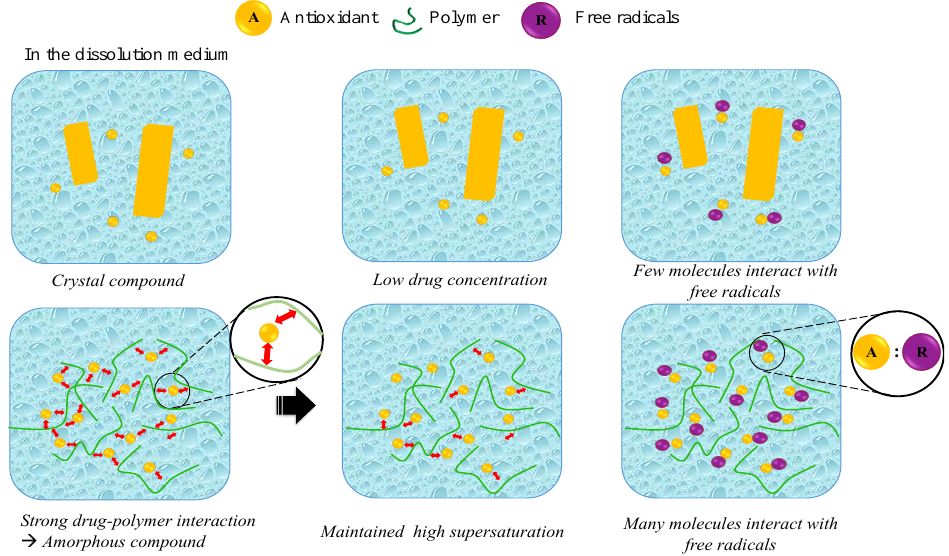
Figure 9. The schematic illustration of the antioxidant activity mechanism of the drug in amorphous solid dispersion.